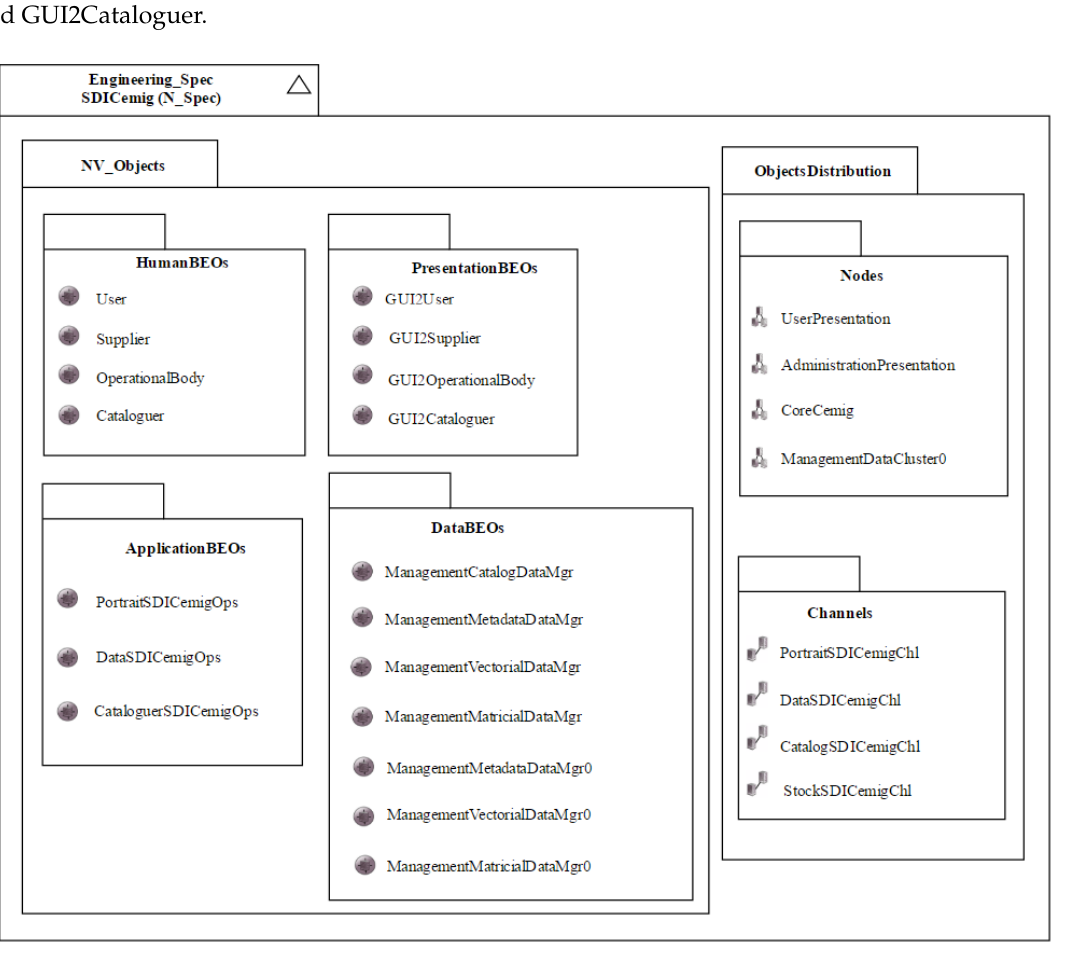
Figure 11. Overall organization of the Engineering objects in